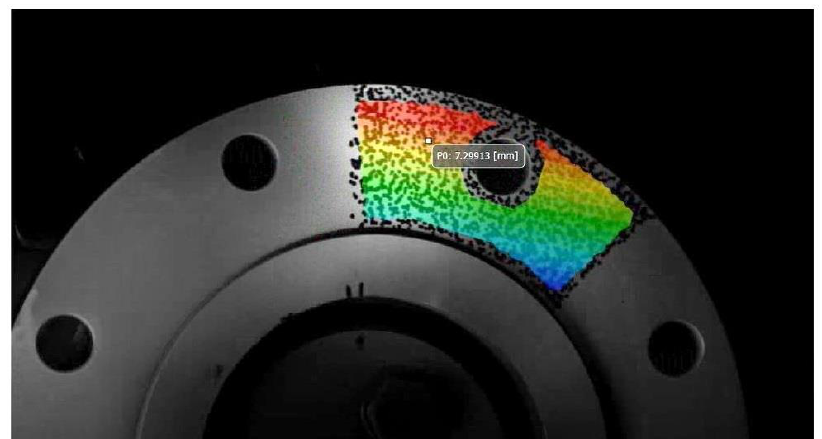
Figure 16. Flange when the left engine is running, together with an instantaneous value of the linear displacement u 0 of the representative point P 0 .